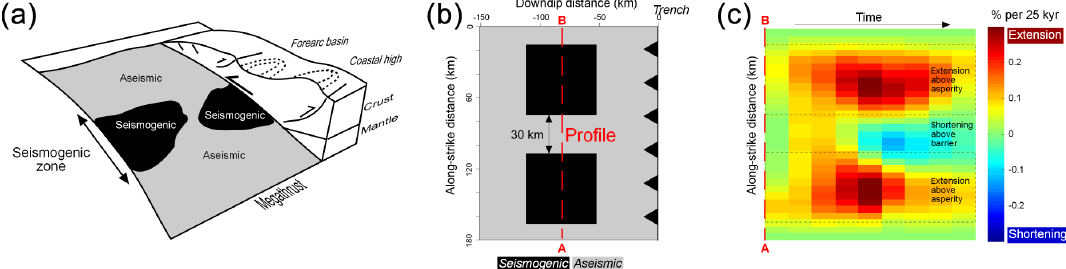
Figure 16. Seismotectonic evolution of subduction zone forearcs as suggested by elastoplastic subduction zone megathrust models: (a) spatial correlation between forearc topography and the seismogenic zone along subduction megathrust suggested by 2-D models of Rosenau and Oncken (2009). (b) Set-up of seismotectonic scale model with two seismogenic patches. (c) Evolution of along-strike strain emerging from the model shown in (b) . Note the correlation between along-strike shortening and extension with aseismic and seismic areas along the